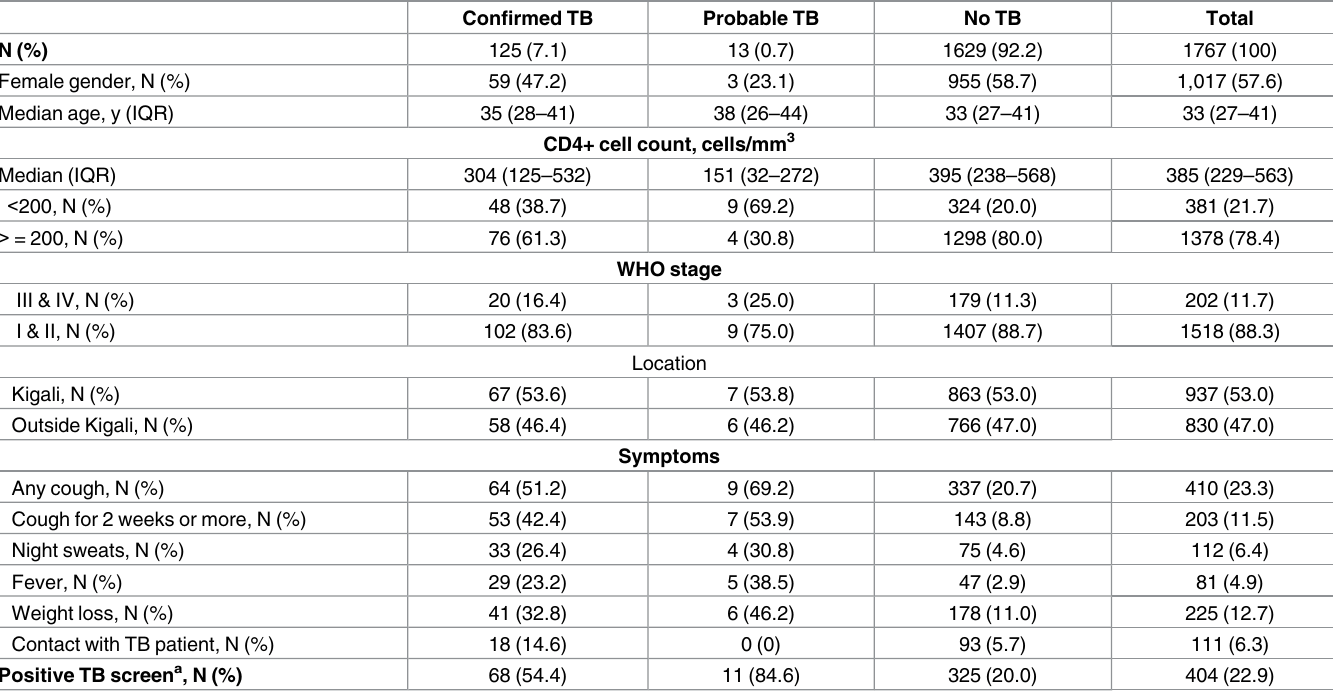
Table 2. Baseline Characteristics of Study